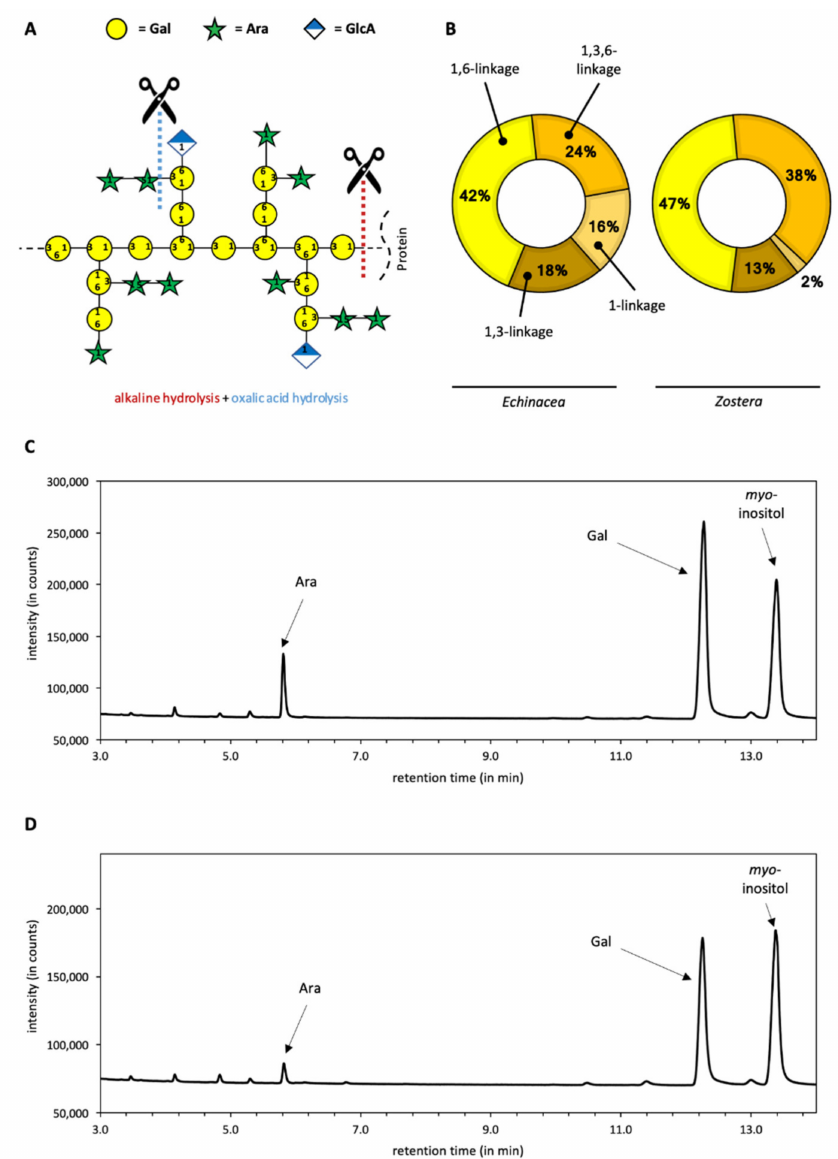
Figure 1. Overview on characteristics of galactans from Echinacea and Zostera . ( A ) Schematic illustration of the degradation process by alkaline and oxalic acid treatment based on a hypothetical AGP model. ( B ) Linkage-type composition of galactose part of both galactans according to [17,18]. ( C ) Gas chromatogram of the resulting derivatized monosaccharides (myo-inositol is used as internal standard) in galactans from Echinacea . ( D ) Gas chromatogram of the derivatized monosaccharides from Zostera